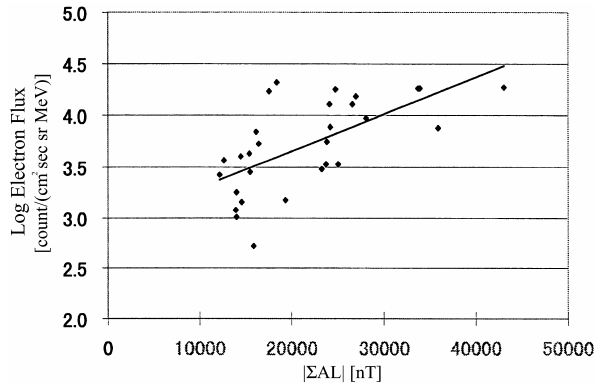
Fig. 2. Scatter plots of the peak electron flux versus the absolute value of 6AL for all 29 events. The solid line indicates the least- squares fit.